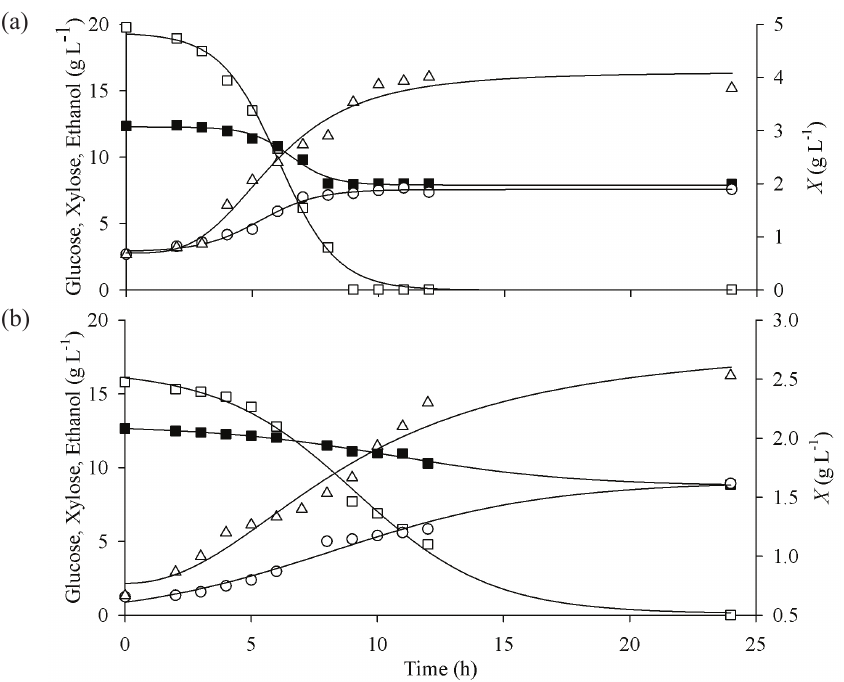
Fig. 4 – Changes in glucose (  ), xylose (  ), ethanol (  ), and cell number (N,  ) concentrations during aerobic (a), and anaerobic cultivation (b) of genetically engi- neered S. cerevisiae on control media containing glucose and xylose in shake flasks